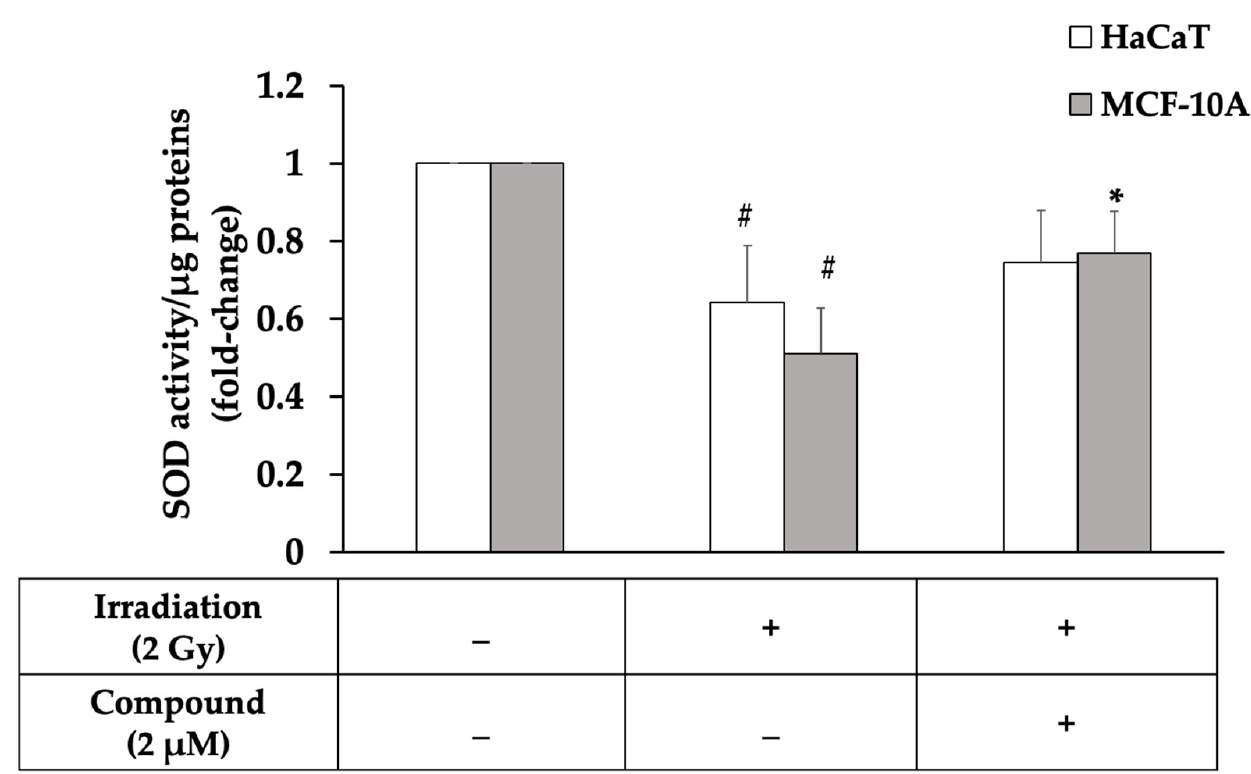
Figure 4. Superoxide dismutase (SOD) activity in normal cells and HaCaT and MCF-10A cell lines treated with interruptin C derived from C. terminans before 2-Gy irradiation. Data represent the mean ± SD from three independent experiments. The significance of the mean differences was analyzed using Kruskal–Wallis with Dunn’s test. * p < 0.05 compared to the irradiation-alone group. # p < 0.05 compared to the nonirradiated group.